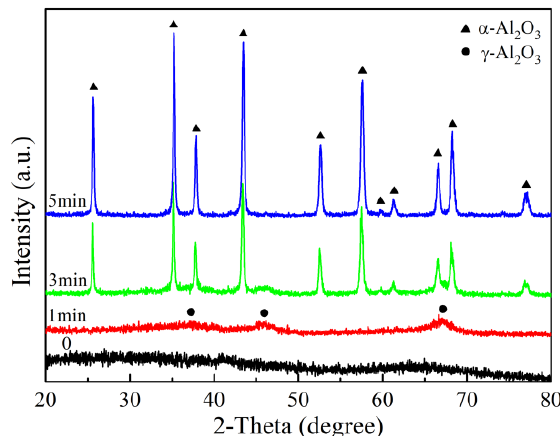
Figure 7. XRD patterns of Al 2 O 3 fibers calcined at 1400 °C.